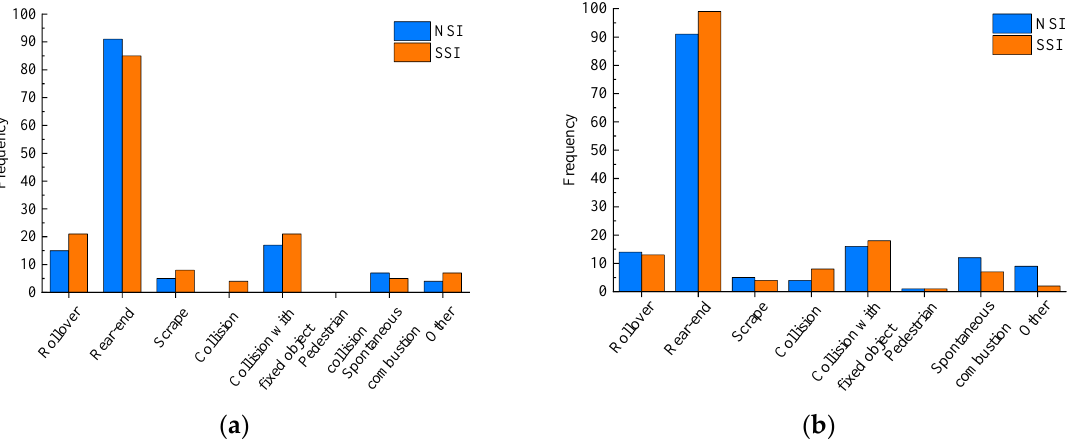
Figure 6. ( a ) Accident type in Section Ⅰ ; ( b ) Accident type in Section Ⅱ .